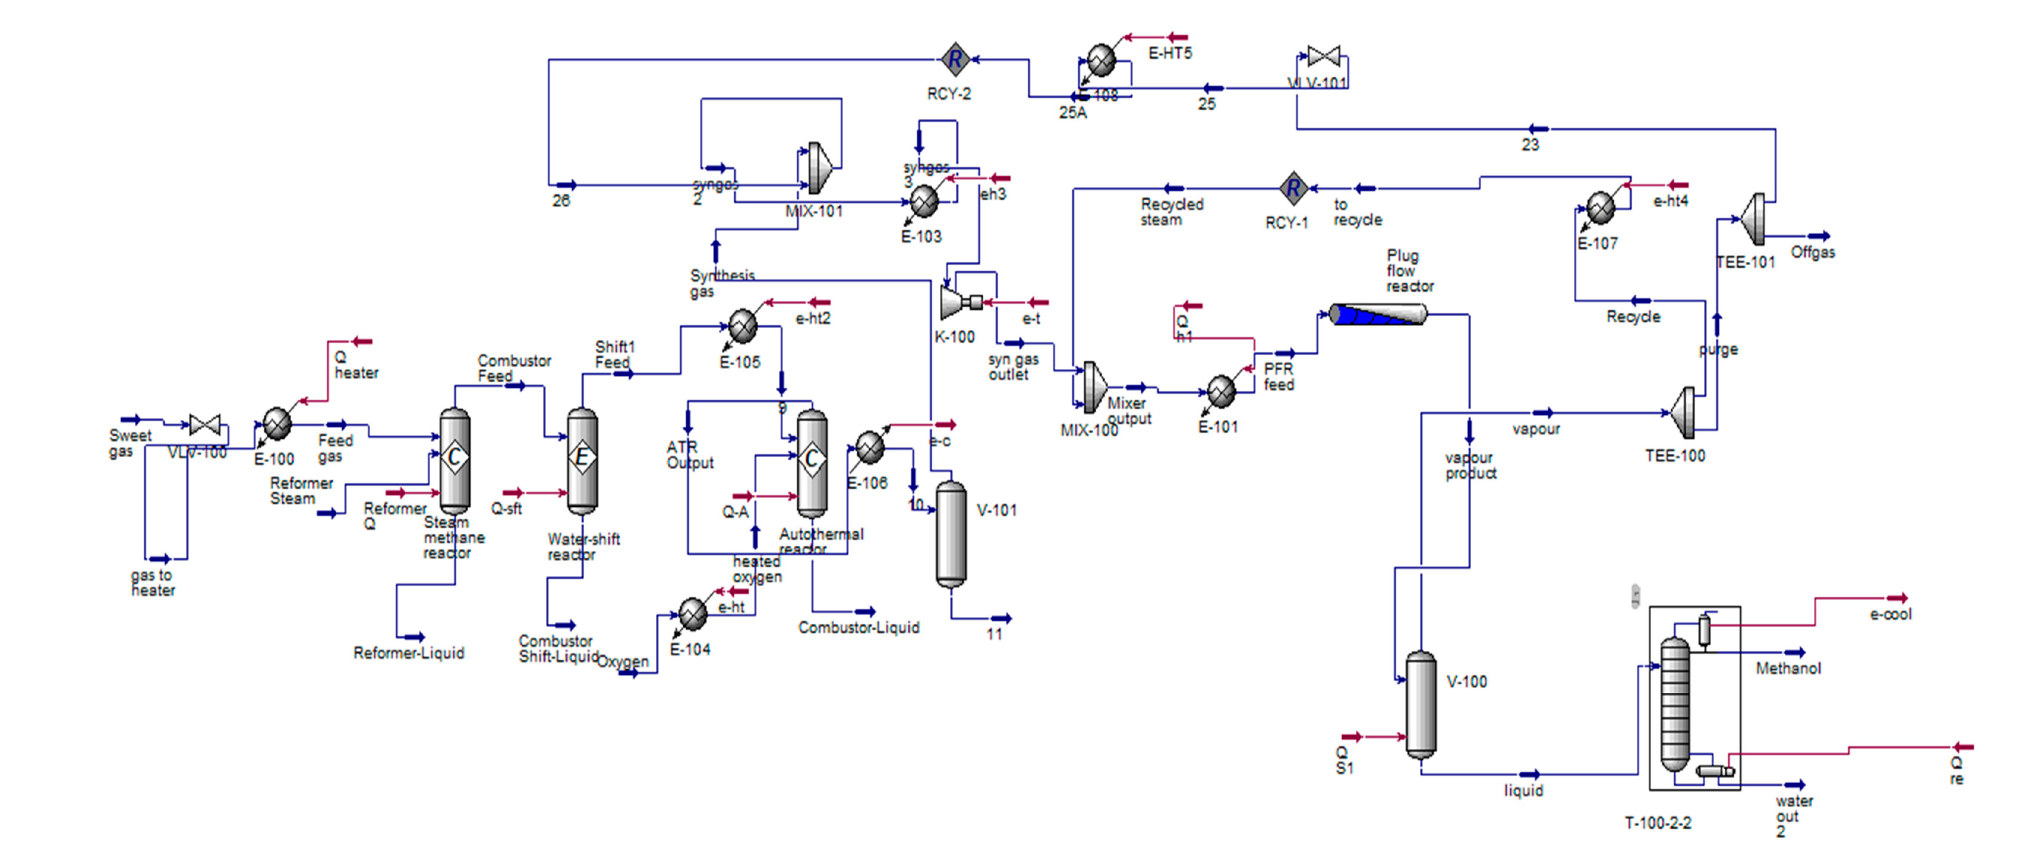
Figure 6. GTM process flow diagram in ASPEN HYSYS.